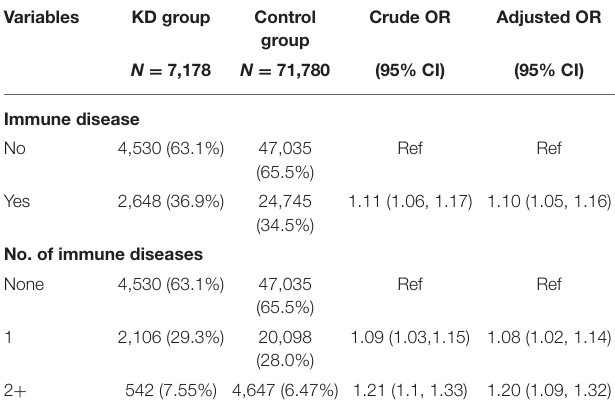
Model adjusted for week, age at pregnancy. KD, Kawasaki disease.